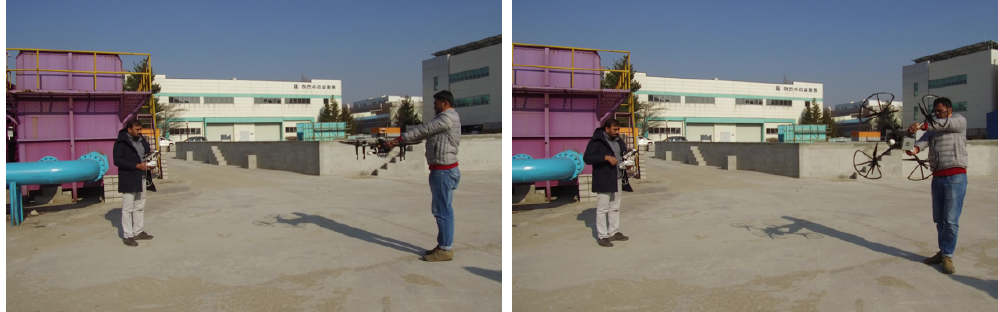
Figure 6. UAV calibration at the experimental site: ( Left ) Holding it horizontally and ( Right ) vertically.